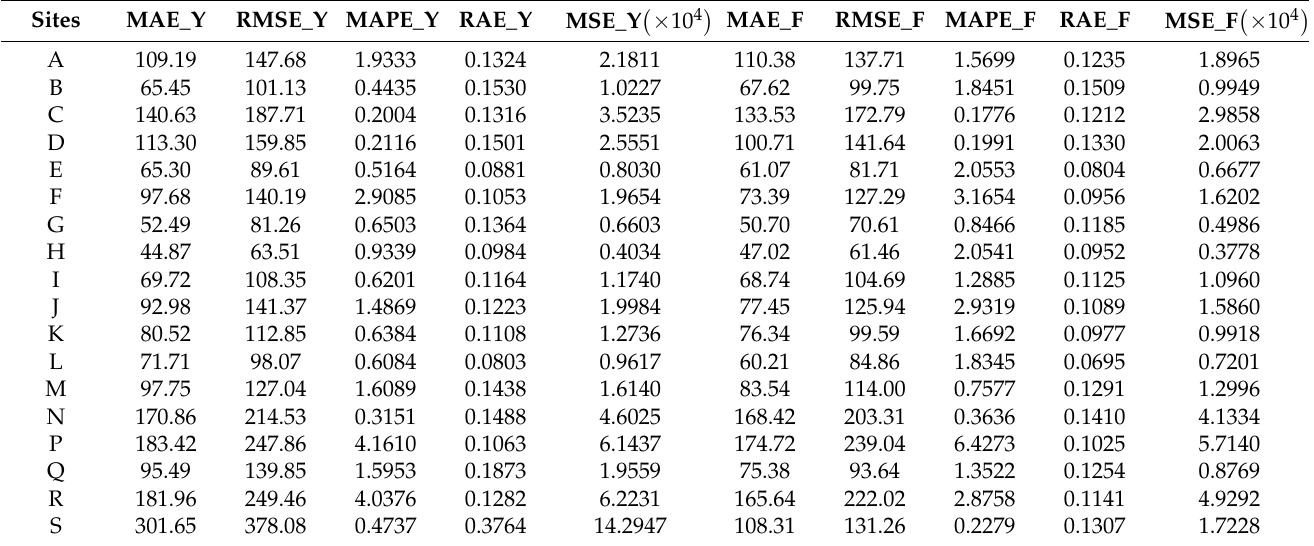
Table 10. Error analysis for the estimated normal distribution (Y) and the estimated fitness curve (F), where the first five columns describe the error in the PDF and the last five columns describe the errors in the fitness curve for the 8 GHz horizontal